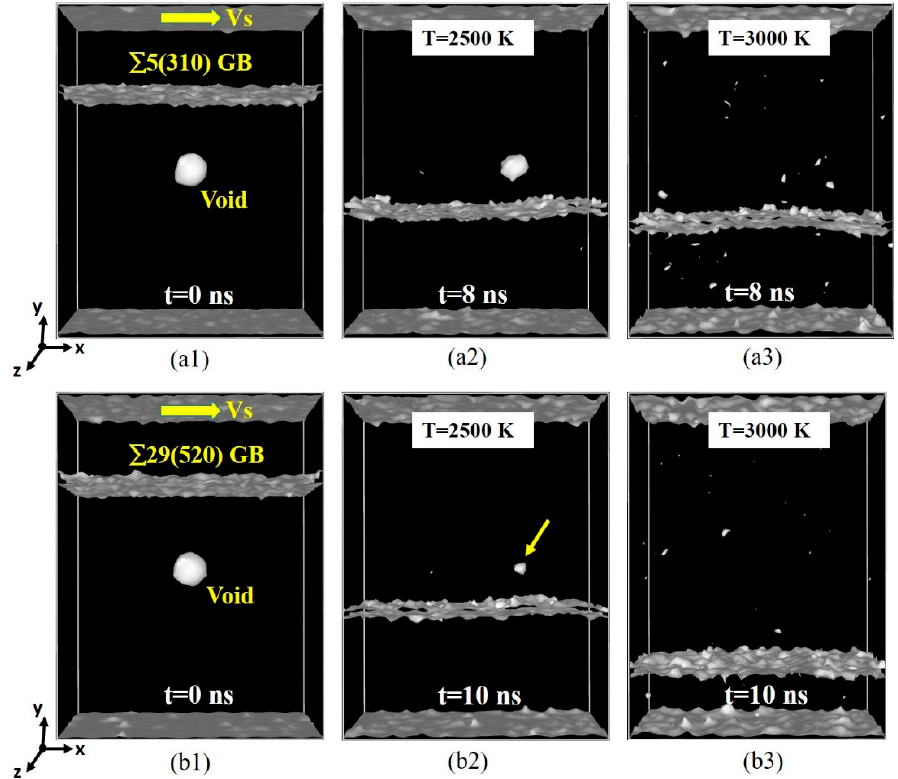
Figure 4. Snapshots of the interaction between GB and void at 2500 K and 3000 K. ( a1 – a3 ) Σ 5(310) GB, ( b1 – b3 ) Σ 29(520) GB. The extracted profile of GB and void was presented using the dislocation extraction algorithm. The dynamic process of GB-void interaction at 3000 K is shown in Supplementary Videos S1 and S2.